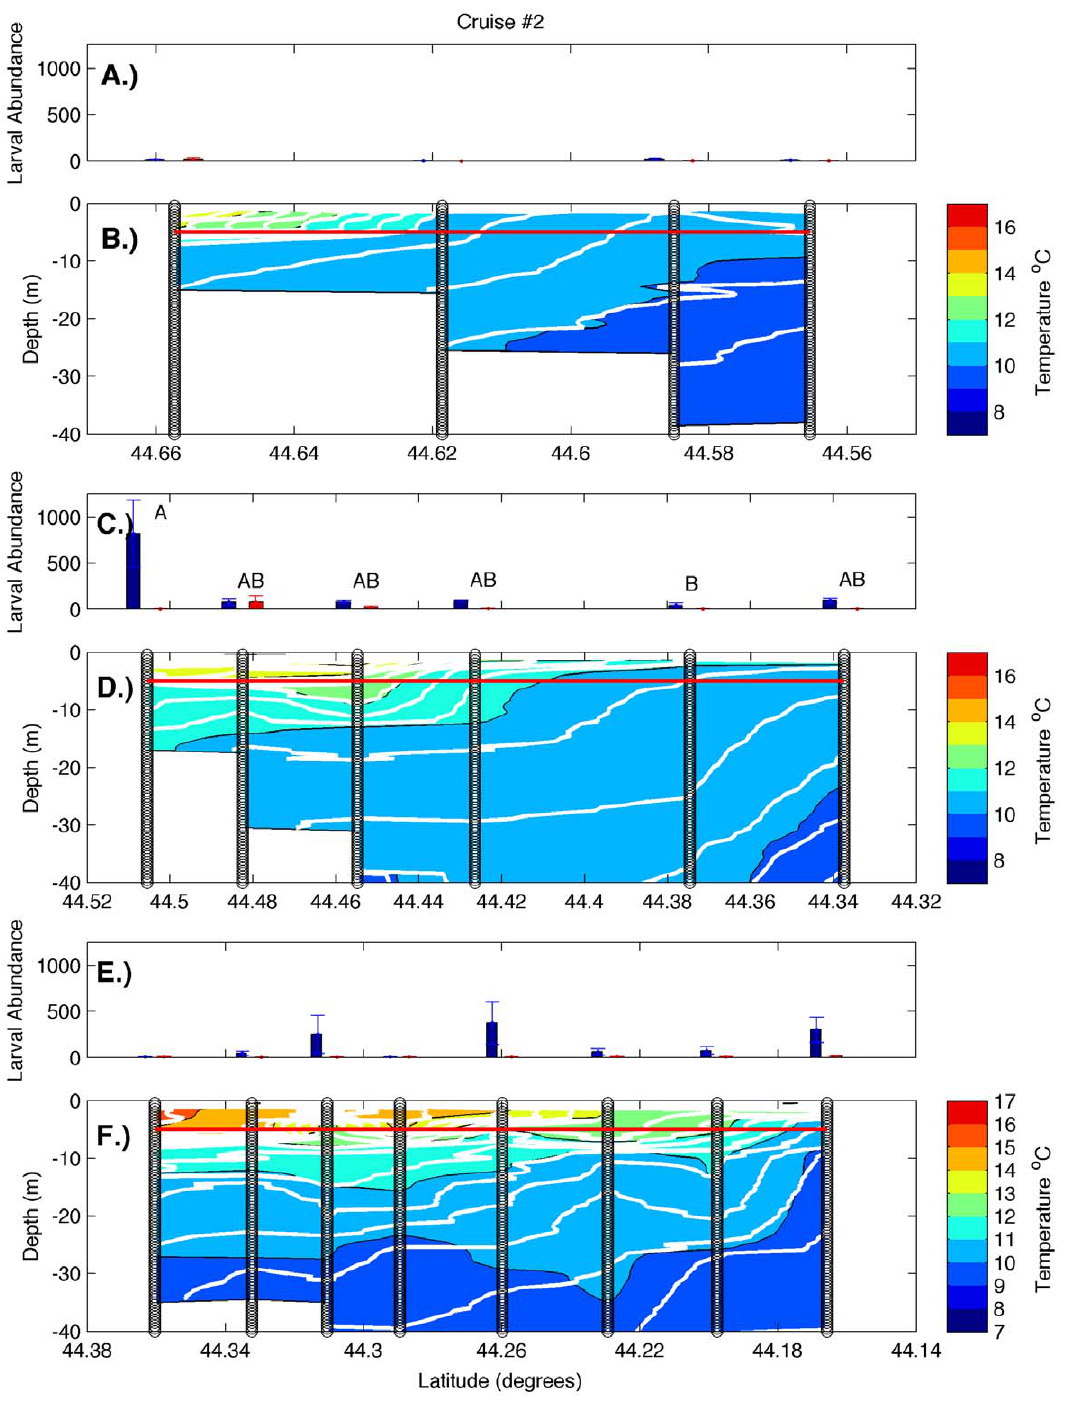
Figure 3. Larval abundance and water column structure on July 20–22, 2010. Panels represent larval abundance and water column structure, respectively, for transects 1 (A, B), 2 (C, D), and 3 (E, F). Larval abundance is presented as larvae m 2 3 at 5 m (blue bars) and 0.25 m (red bars). Error bars represent one standard error. The red line indicates the depth at which 5 m samples were collected. Variation in larval density among stations was only significant on transect 2 (one-way ANOVA, p , 0.05), and letters indicate 5 m stations that did not differ significantly from one another (Tukey-Kramer post-hoc test, p . 0.05). Vertical black lines represent the locations of CTD and larval sampling stations, color gradations represent water temperatures, and the white contour lines represent isopycnals.